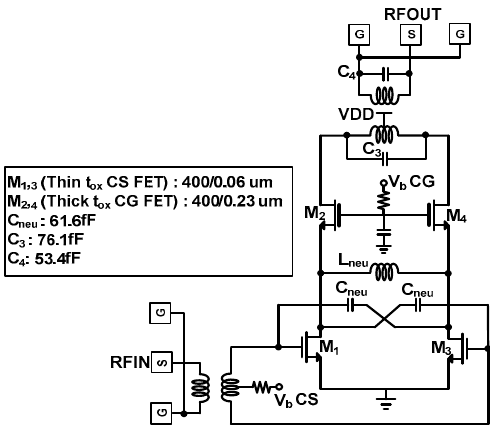
Figure 3. Schematic of the proposed hetero-stacked cascode power amplifier.